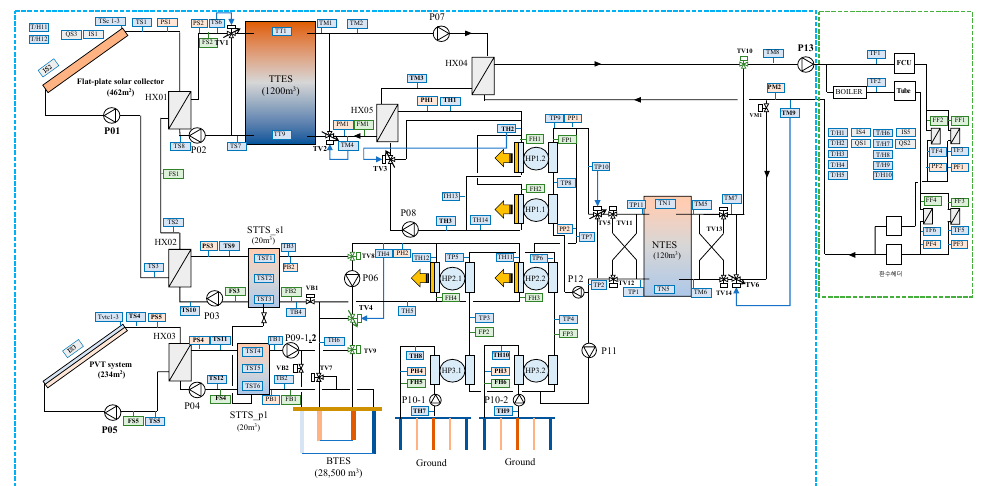
Figure 3. View of detailed monitoring point.